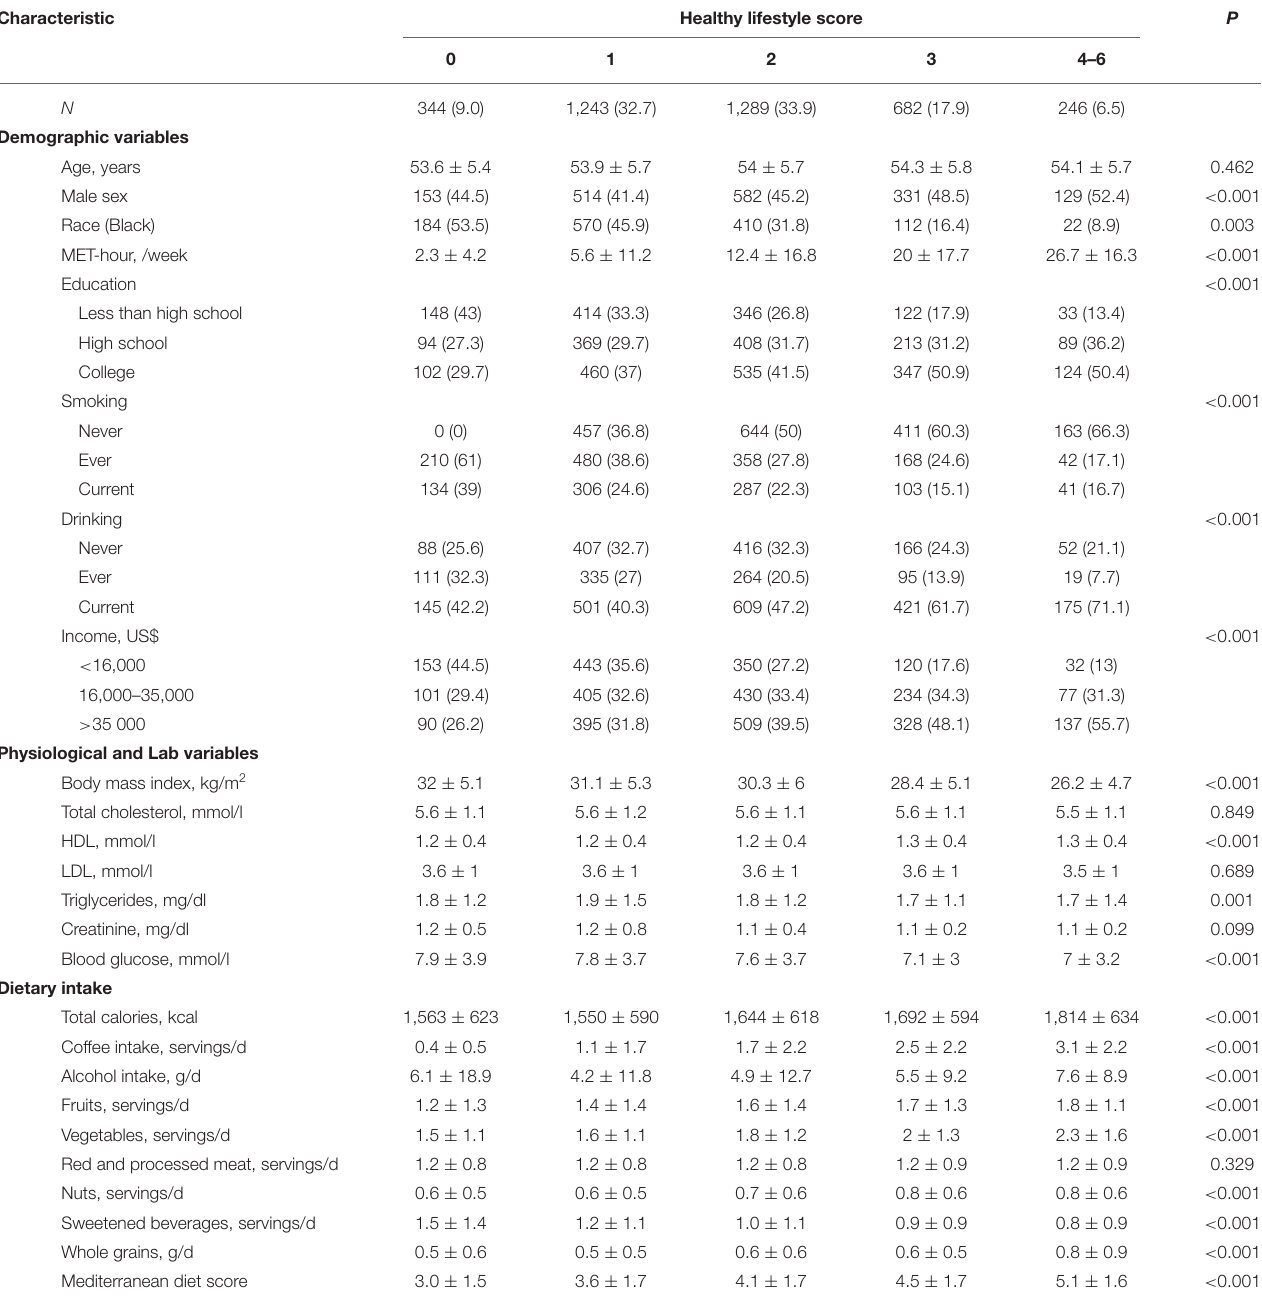
TABLE 1 | Baseline (1987–1989) participant characteristics grouped by healthy lifestyle score.